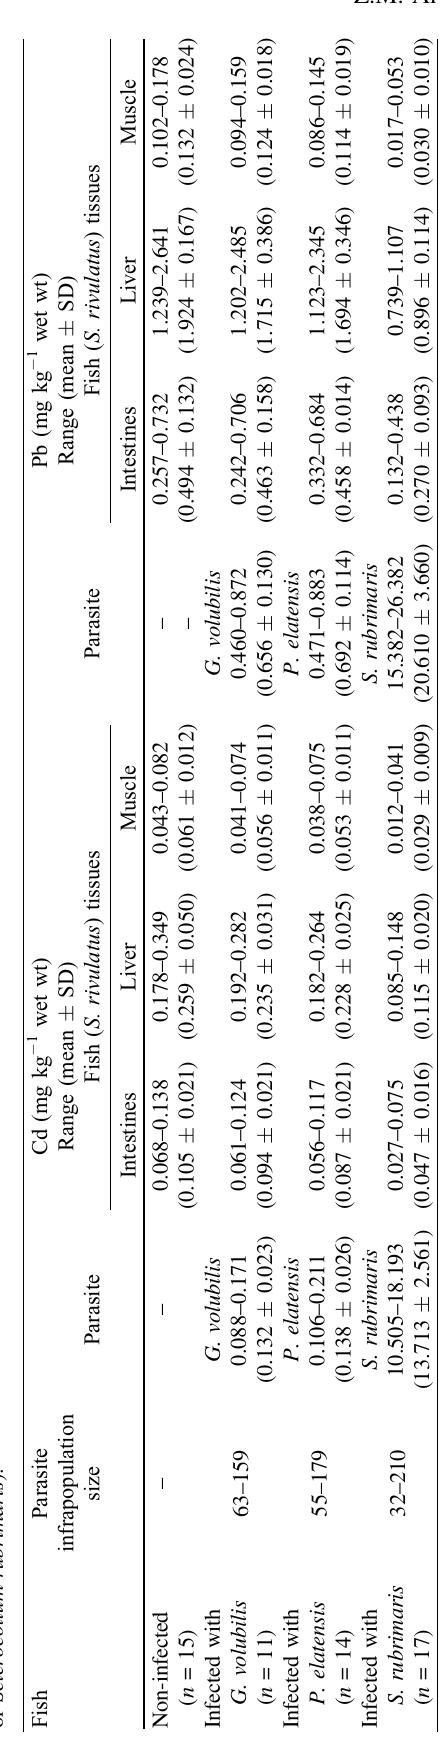
shes. These results clearly indicate that metal accumulation in fi sh tissues was slightly reduced due to infection with the trematode G. volubilis or with the nematode P. elatensis , but dramatically reduced due to infection with the acanthocephalan S. rubrimaris .